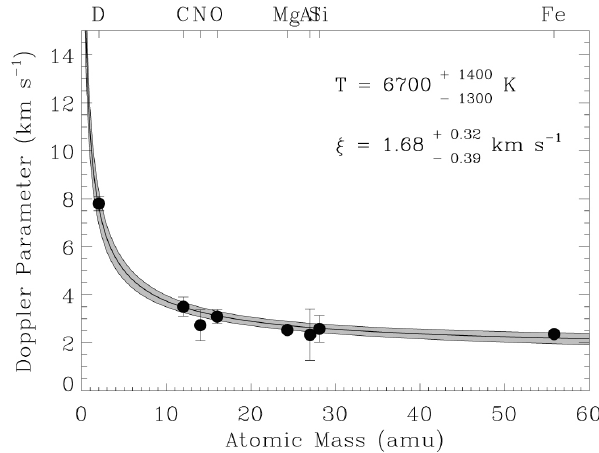
Fig. 3. Expected dependence of the square turbulent line width (normalized by the turbulent velocity amplitude) ξ of direction on the sky. The abscissa is the angle A (in radians) between the line of sight and the direction of the local interstellar magnetic field. The three curves correspond to values of (cid:15) = 0 (solid line), 0.2 (dashed line), and 0.5 (dotted line).